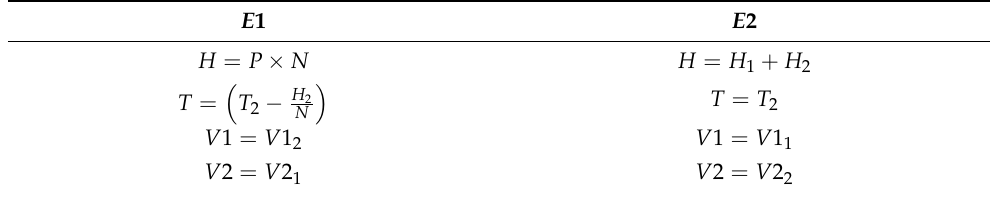
Table 2. Reassigning the event values for respiratory events when separated by a pulse